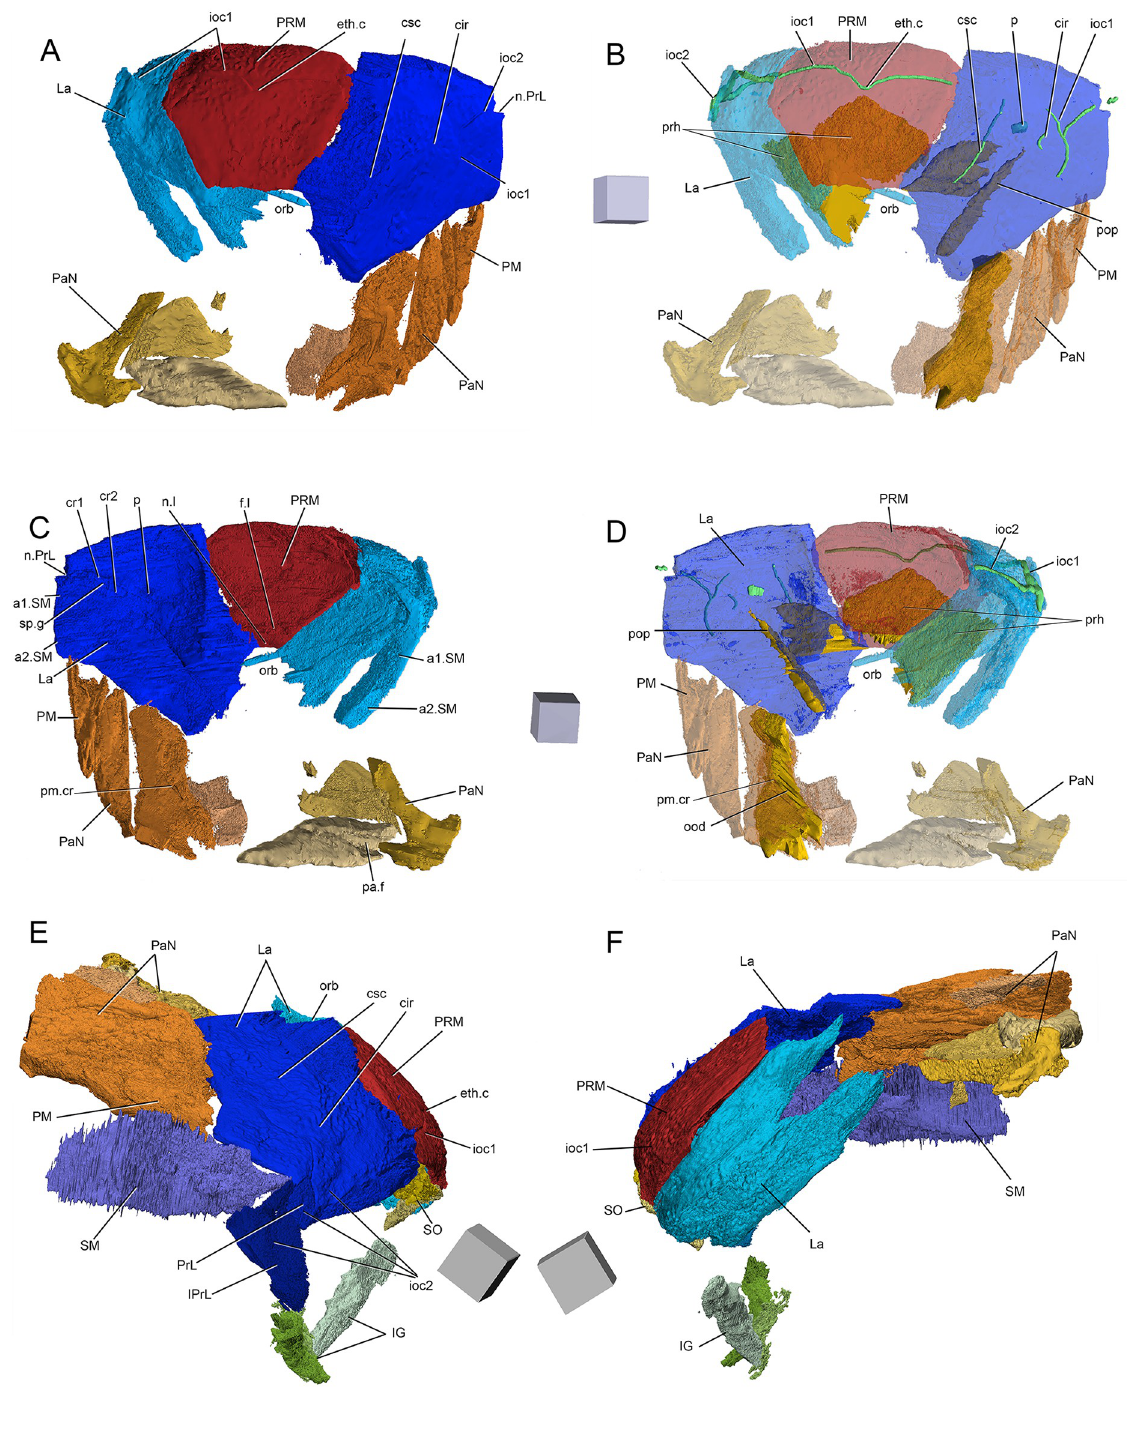
Fig 4. Bothriolepis dairbhrensis sp. nov. Incomplete head elements of specimen NHMP 59677, restored in anatomical position specimen after CT-scanning and segmentation (images generated with Adobe Acrobat (A-D) and Materialise 3-matic (E-F). A, C. skull roof in dorsal view. D, E. skull roof in ventral view (C and E with dermal plates rendered semi-transparent). E-F. Skull roof in right lateral (E) and left lateral (F) views. Edges of scale cube 10 mm.